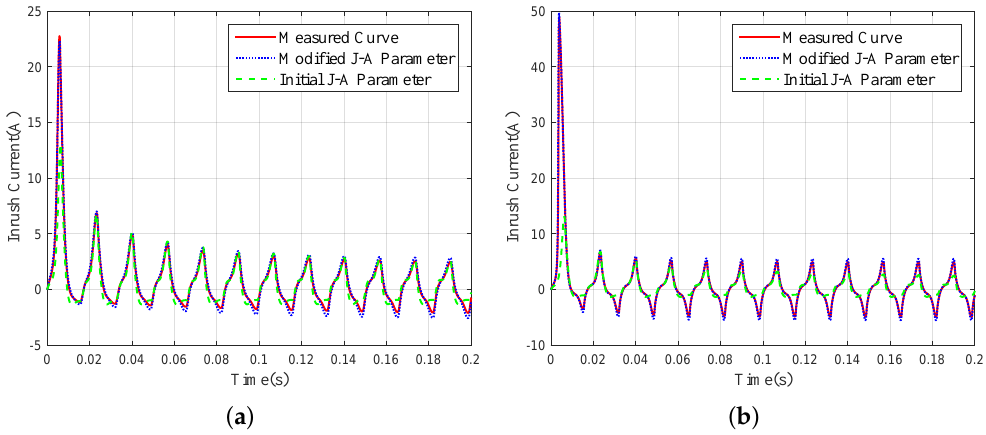
Figure 10. Experimental results of the proposed algorithm on measured inrush current curves from experiment set 1 ( a ) and set 2 ( b